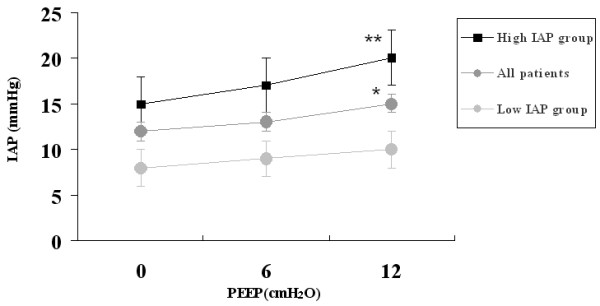
Effects of PEEP on IAP measure in all patients (n = 30), low IAP group (n = 15) and high IAP group (n = 15). *P < 0.05 PEEP0 vs PEEP12. **P < 0.01 PEEP0 vs PEEP12. IAP, intra-abdominal pressure; PEEP, positive end-expiratory pressure.